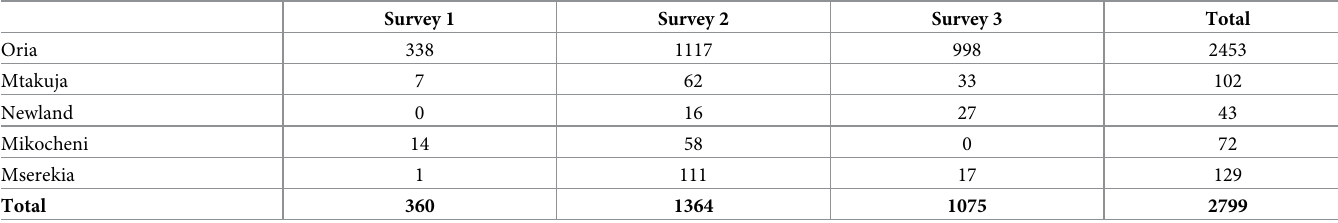
Table 3. Anopheles mosquitoes collected in each village. Survey 1 Survey 2 Survey